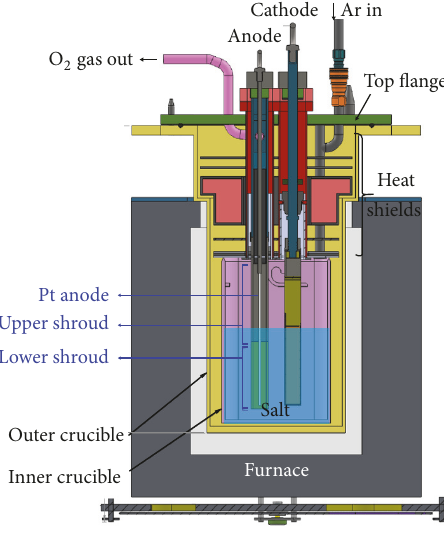
Figure 1: Drawing of the OR apparatus used in this